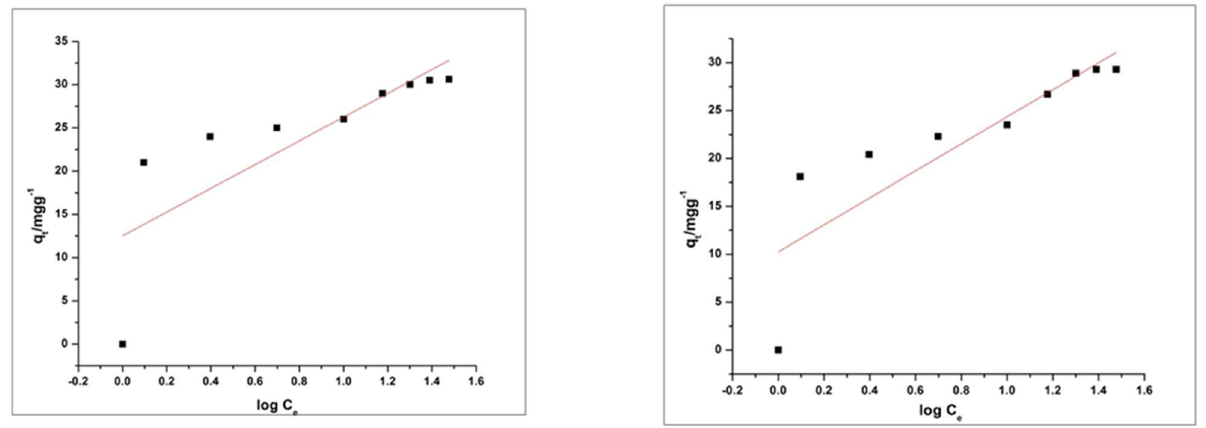
Figure 24. Temkin adsorption isotherm of MO and